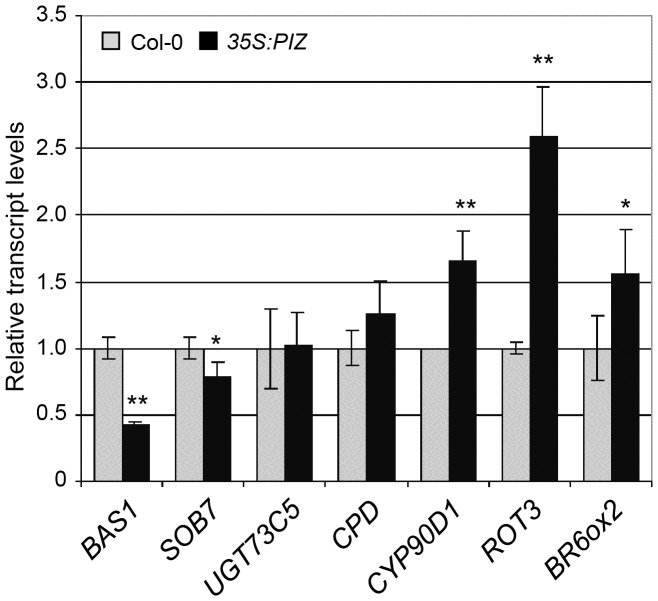
Overexpression of PIZ modifies the expression of BR related genes.Quantitative PCR analysis of BAS1, SOB7 and UGT73C5, implicated in BR metabolism, and CPD, CYP90D1, ROT3 and BR6ox2, involved in BR biosynthesis. RNA was isolated from aerial tissues of 17-day-old plants. Mean values of three biological replicates, normalised to PP2AA3 and shown relative to Col-0 levels with SD. * and ** represent significant difference at p<0.1 and p<0.05, respectively.